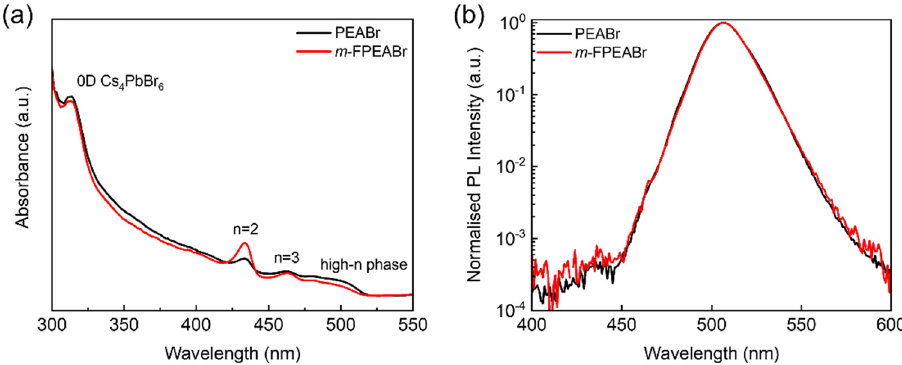
Figure 4. ( a ) Absorption and ( b ) PL spectra of m -FPEABr and PEABr perovskite